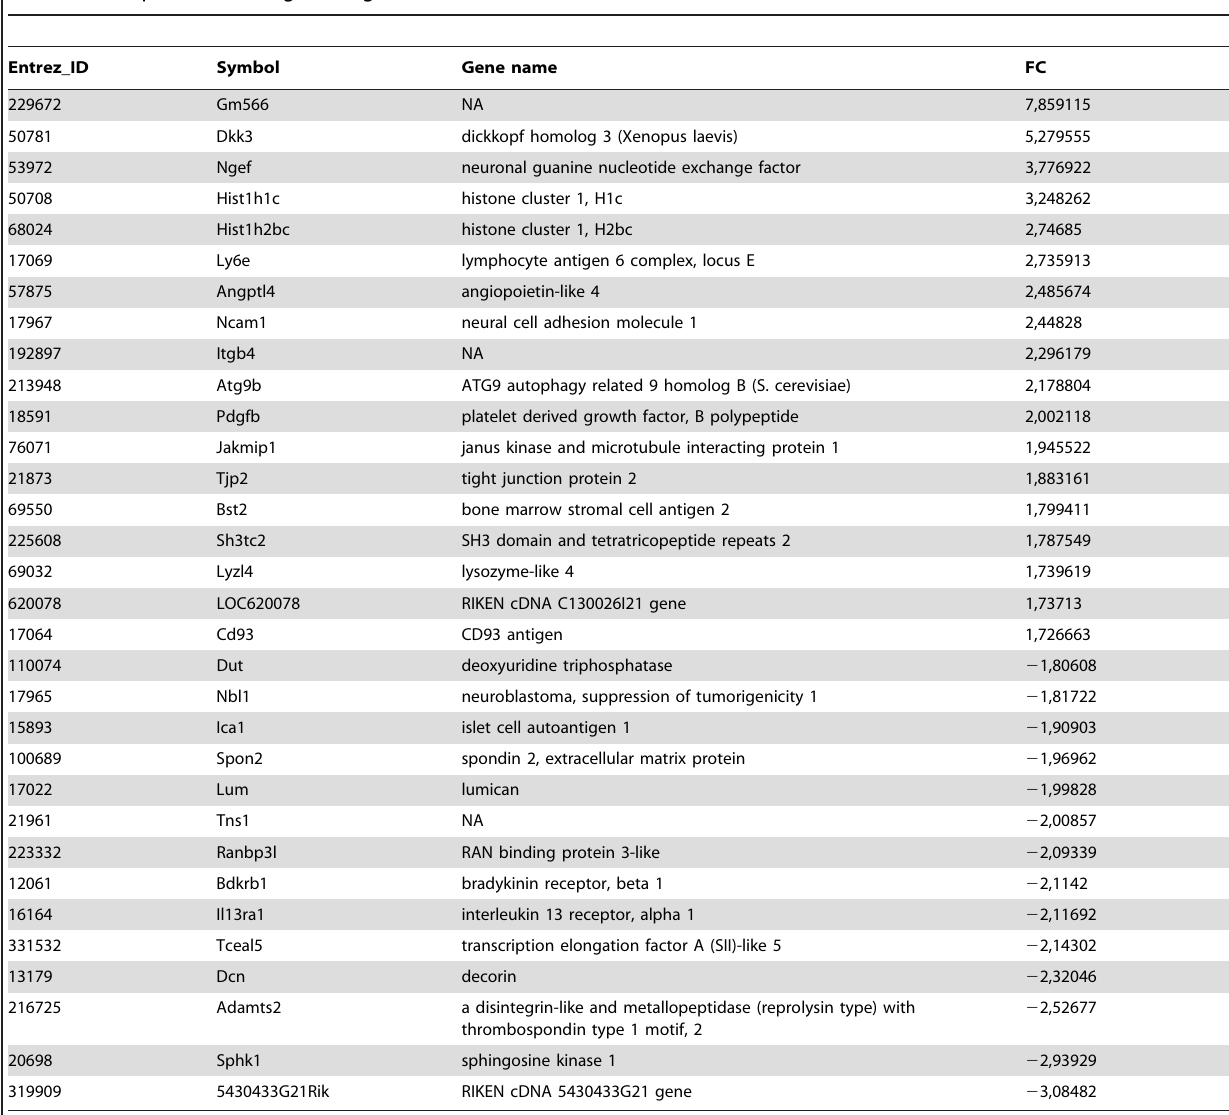
Table 5. Unique Pax6(5a) regulated